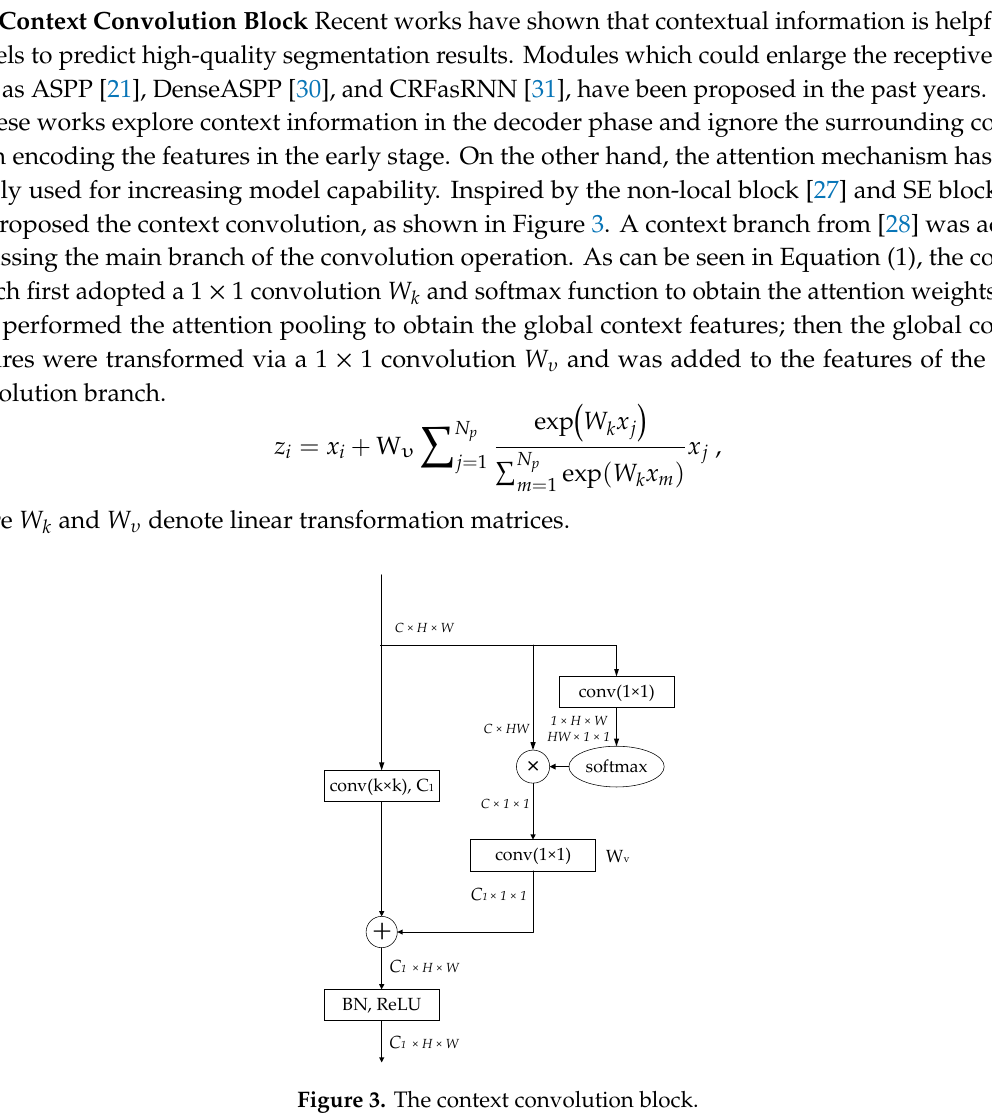
Figure 3. The context convolution block.